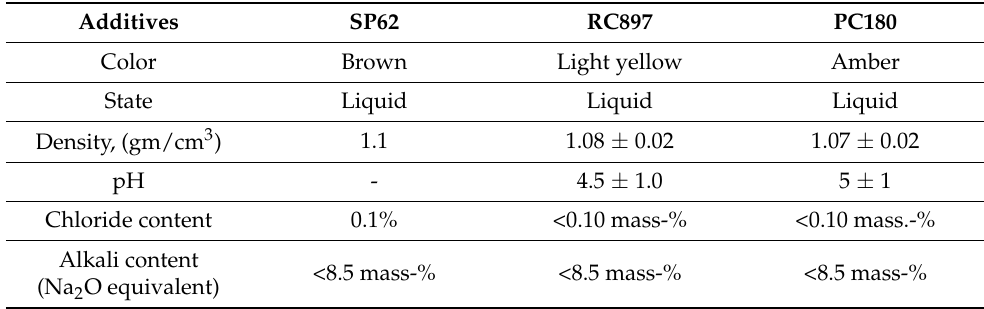
Table 2. Properties of the